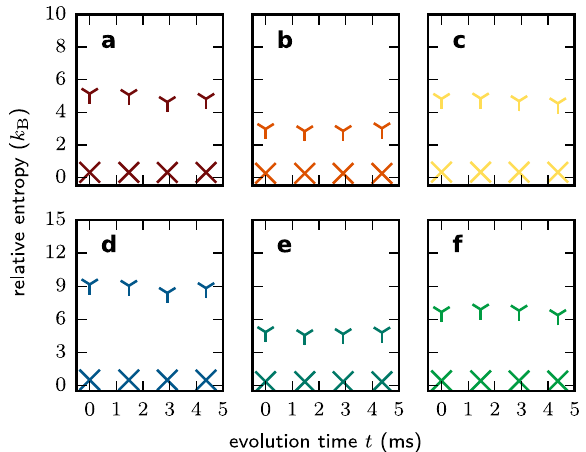
Fig. 3 Linear response regime. a – c Relative entropy D (crosses) and linear response (4) (Y symbol) for the reversed generalized Clausius inequality. d – f Same quantities for the generalized Clausius equality. The linear approximation deviates signi fi cantly from the exact value, indicating that the experiment is performed far from the linear-response